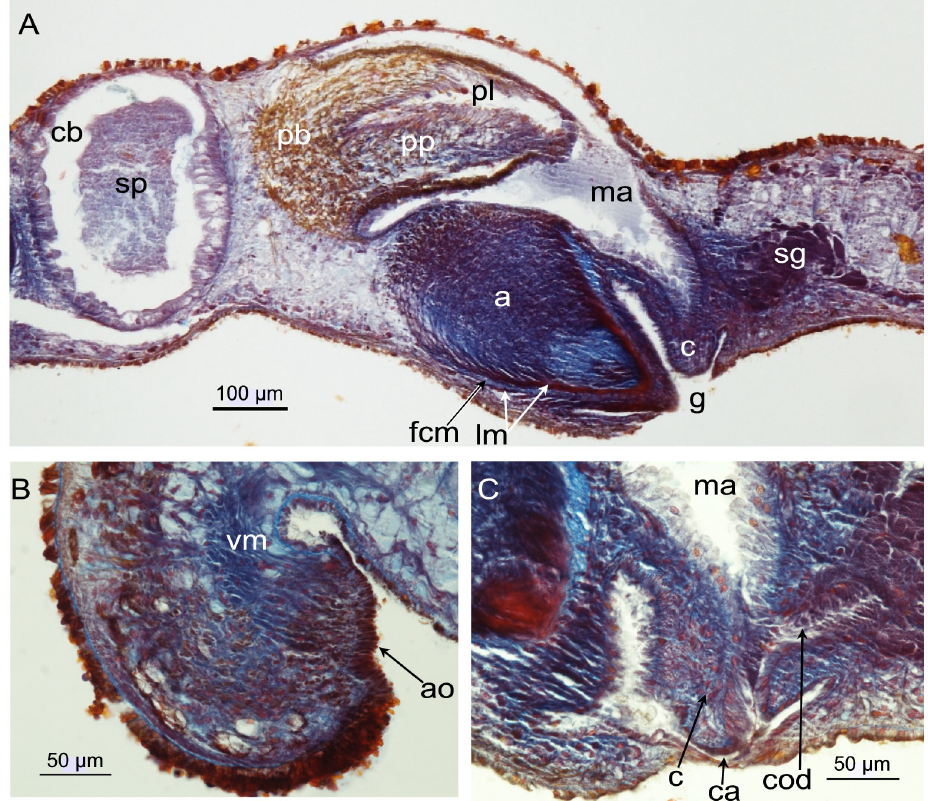
Fig. 4. Dendrocoelum obstinatum Stocchino & Sluys, sp. nov., holotype (ZMA V.Pl. 7264.1). A . Microphotograph of the copulatory apparatus. B . Microphotograph of the anterior adhesive organ with the associated ventral muscles. C . Microphotograph of the cervix-like protrusion of the male atrium, with the opening of the common